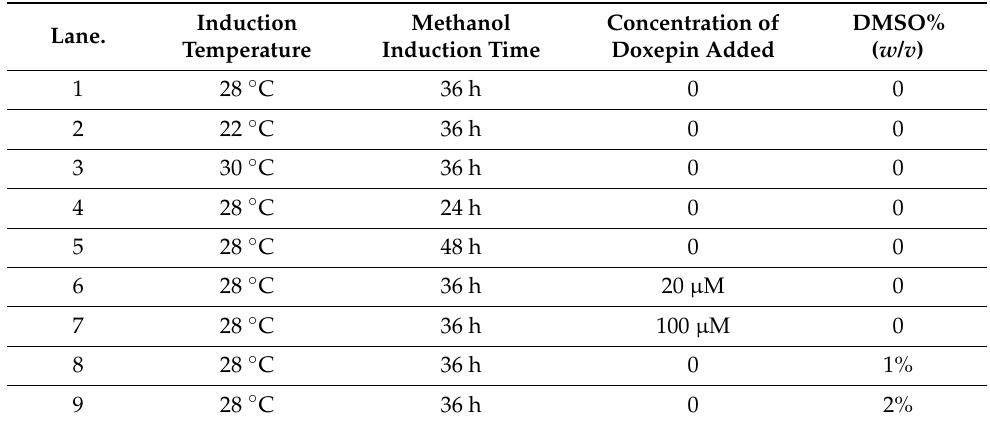
Figure 2. Optimization of H 1 R protein production from a Western blot analysis of protein expression conditions. Each lane represents a distinct set of experimental conditions used to express H 1 R in 4 mL cell culture (see Table 1). The intensity of a protein band appearing just above the 30 kDa molecular weight marker was used to identify optimal expression conditions. Cell culture conditions tested in lanes 6 and 7 were found to be optimal, and conditions in lane 6 were used for subsequent large-scale protein production. Table 1. Parameters used for testing H 1 R expression conditions corresponding to the Western blot analysis in Figure 2.